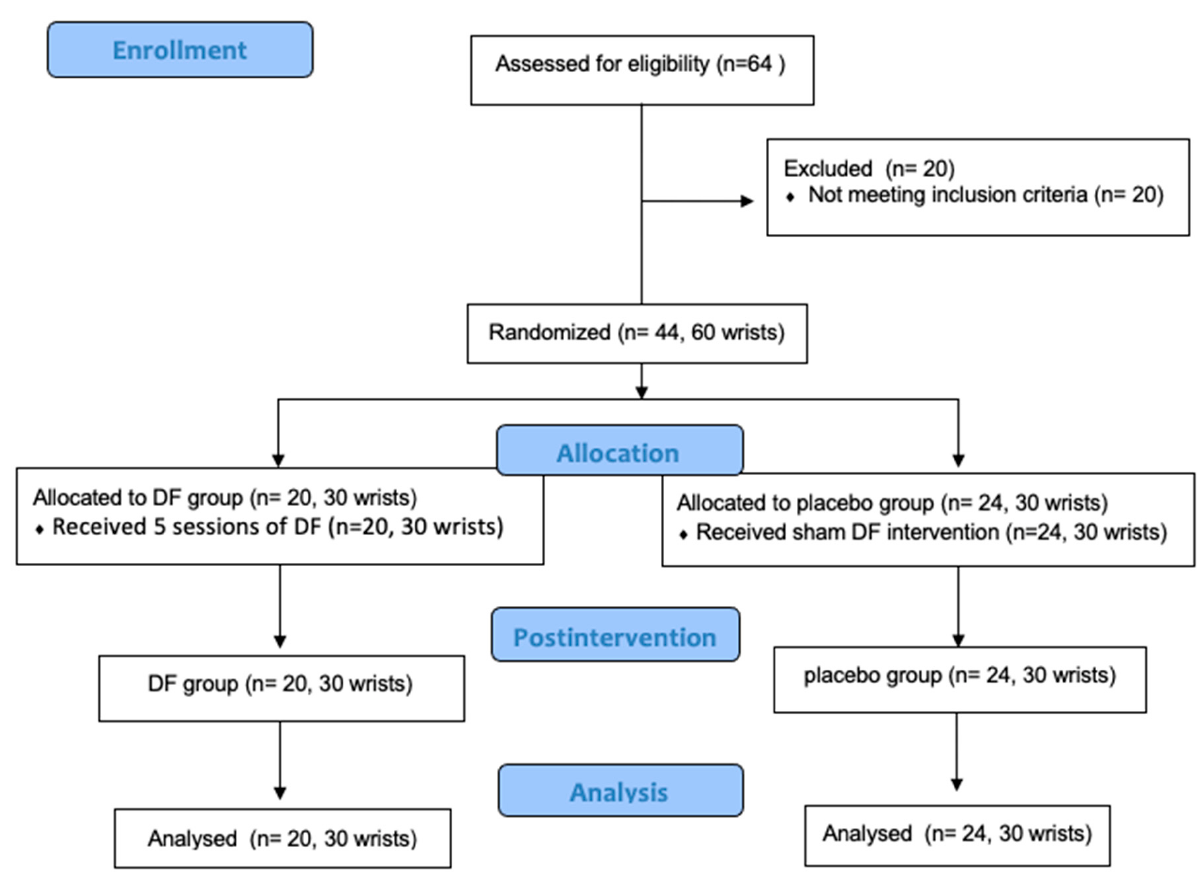
Figure 2. CONSORT flow diagram of the study.